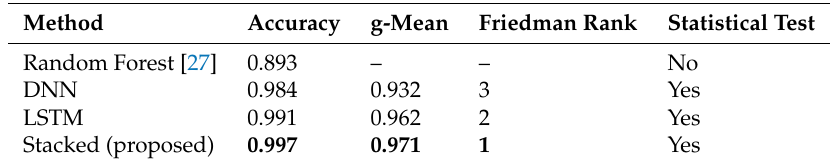
Table 10. Performance evaluation of the IoT-23 test set; best results are indicated with bold. g-mean, geometric mean.